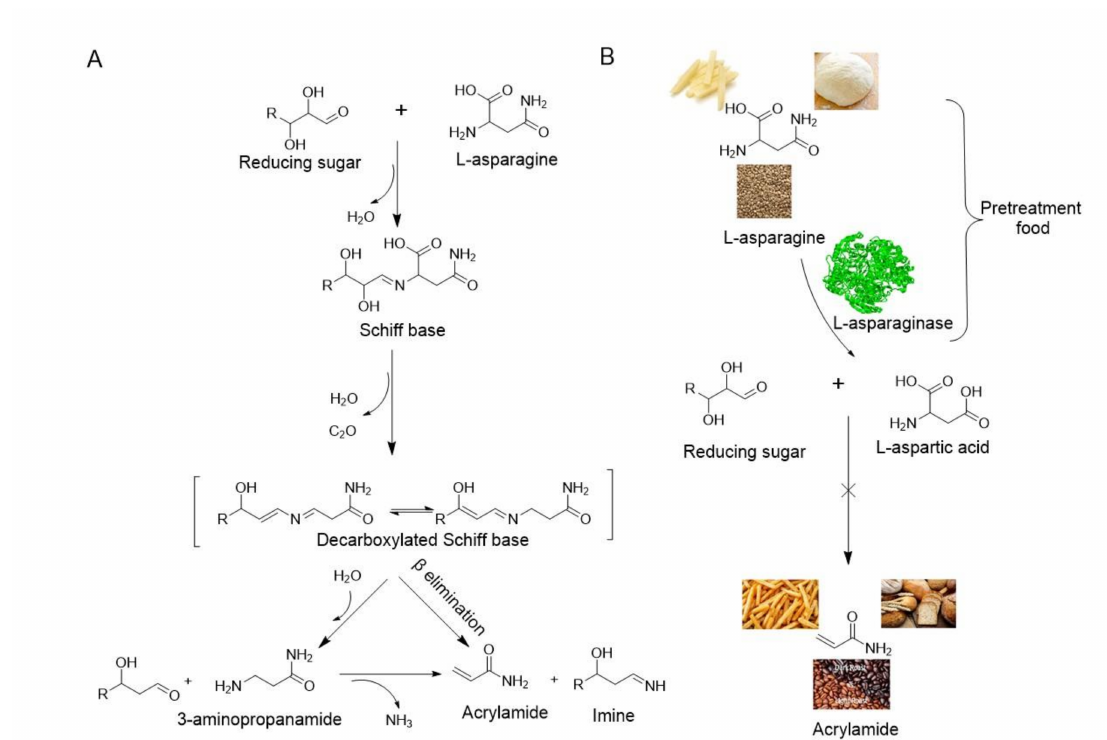
Figure 2. Mechanism of acrylamide formation and acrylamide mitigation through L-asparaginase: ( A ) Acrylamide formed between reducing sugars and L-asparagine; ( B ) Acrylamide mitigation in foods through the conversion of L-asparagine to L-aspartic acid by